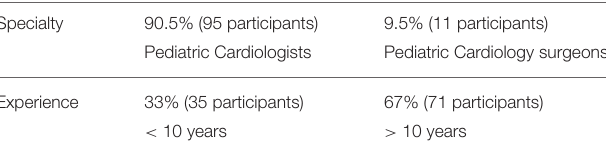
TABLE 1 | Showed the participants characters regarding their field of practice and also the length of experience.